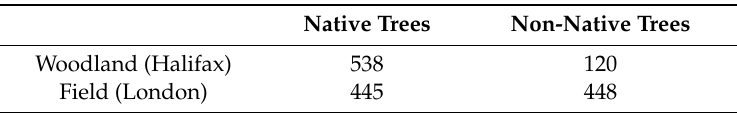
Table A1. Contingency table for test “O” (old neighbourhoods).